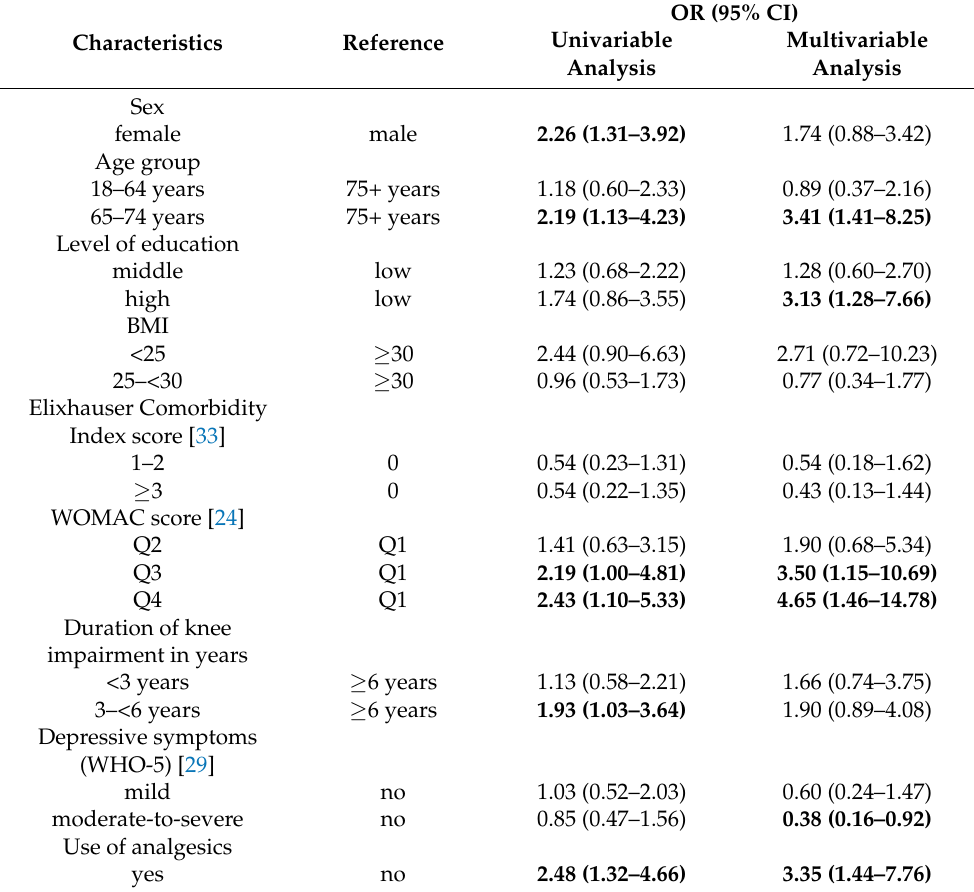
Table 3. Factors associated with a higher utilization of physiotherapy (PT) prior to TKA: results from univariable and multivariable logistic regression analyses (n =